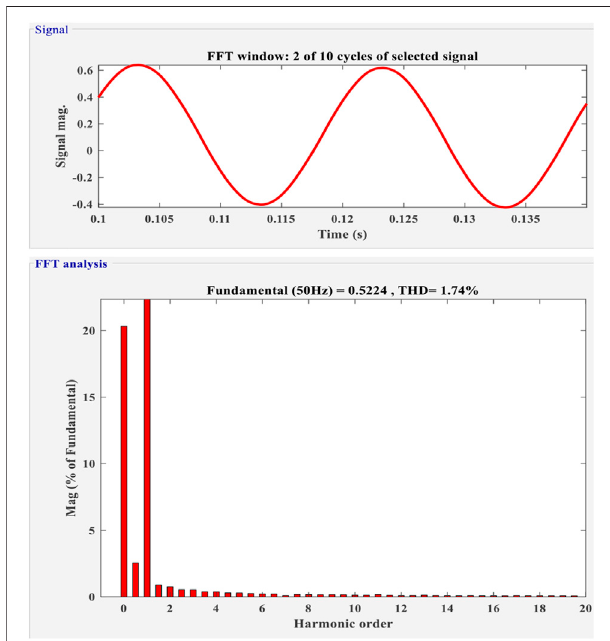
FIGURE20| WithSHAPFforunbalancedlinearloadsourcevoltage(V s ), source current (I s ), load current (I L ), and compensating current (I c ).